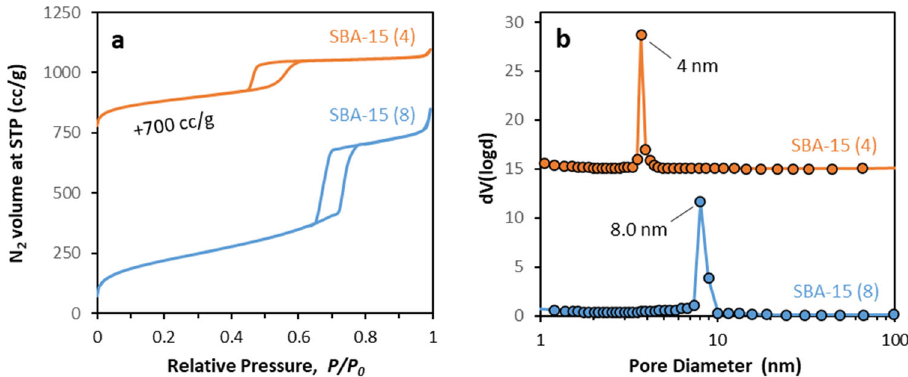
Figure 3. N 2 porosimetry of SBA ‐ 15 mesoporous silicas, ( a ) physisorption isotherms, and ( b ) pore distribution analysis via BJH method.